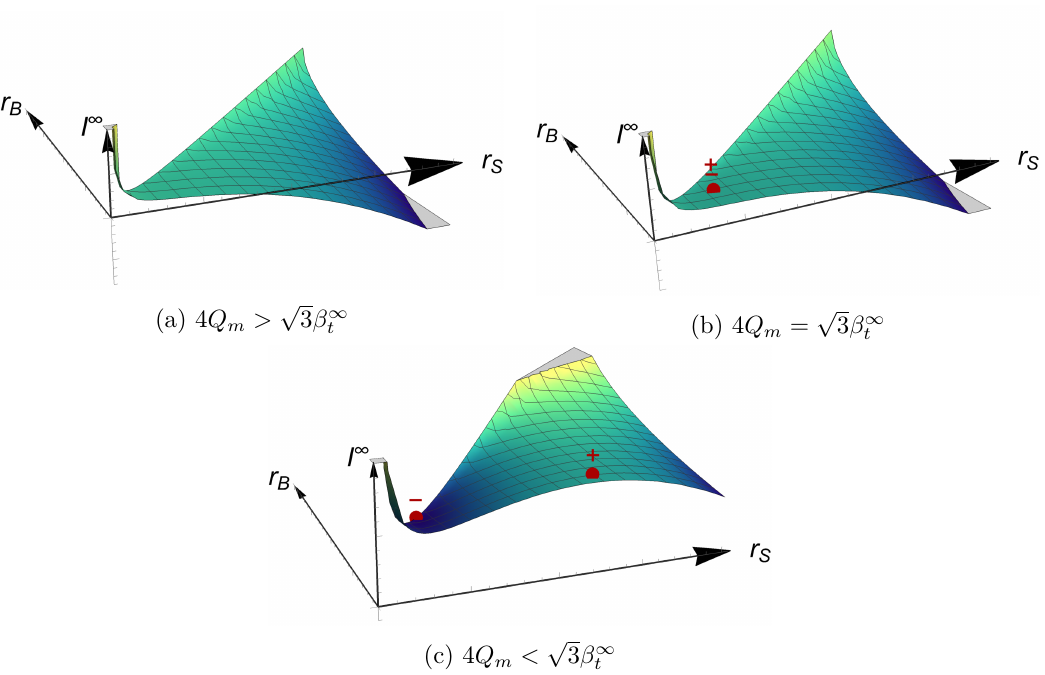
in terms of ( r ) for three regimes of ( Q S , r B BS